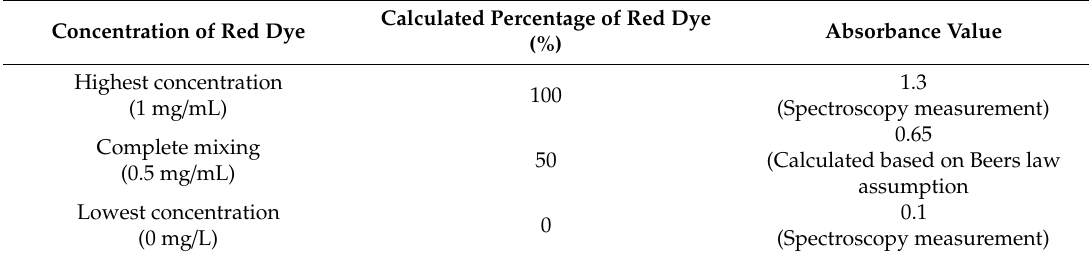
Table 2. Calibration points used to determine the mixing